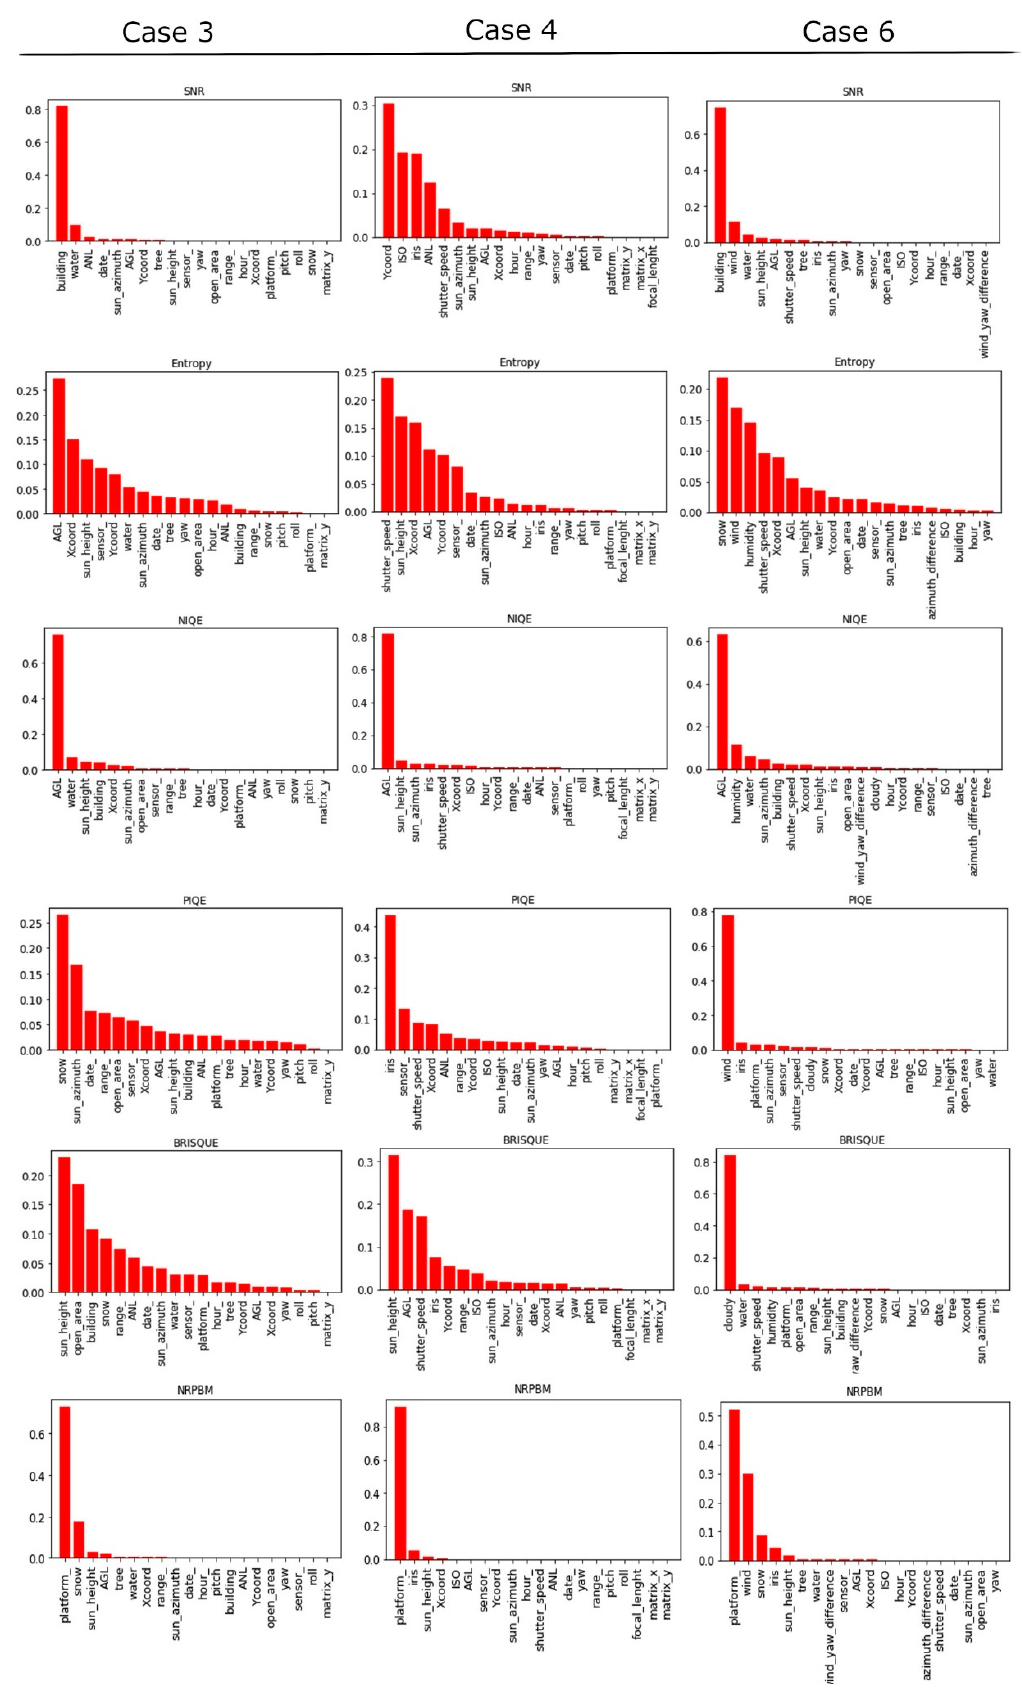
Figure 7. Feature importance analysis for Case 3, Case 4, and Case 6.